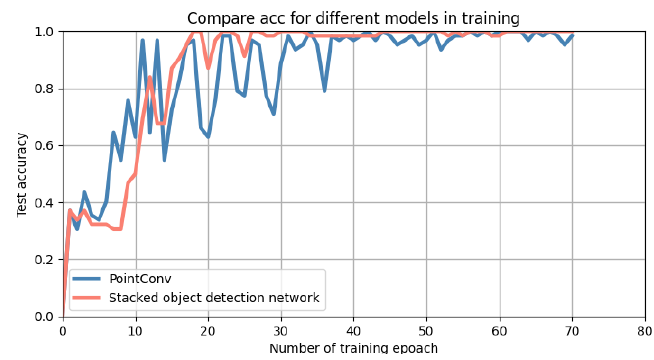
Figure 8. Training Performance. With the increasing number of epochs, the accuracy of SOCN becomes better and smoother as compared to